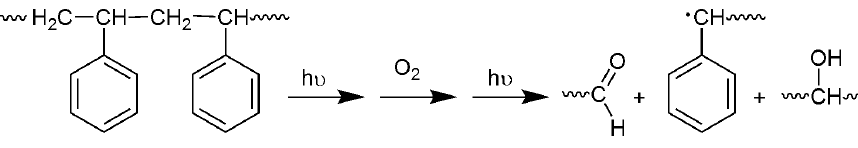
Figure 1. Photooxidative degradation of PS.